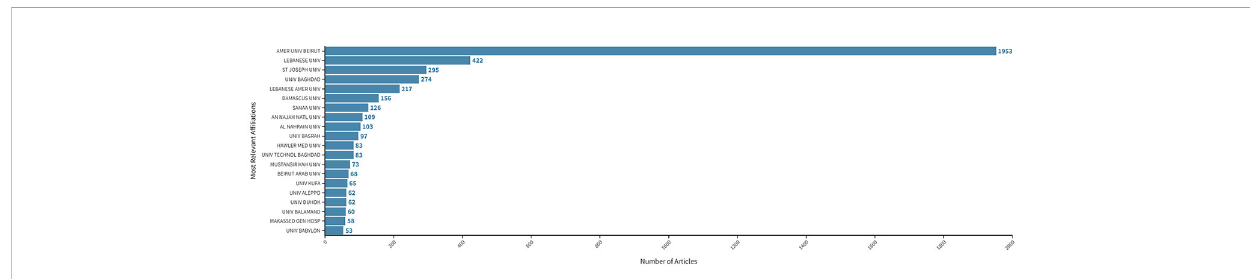
FIGURE 5 Most relevant af fi liations per article on cancer research in FCS in the MENA region from 2000 to 2021. From top to bottom: American University of Beirut, Lebanese University, Saint Joseph University, University of Baghdad, Lebanese American University, Damascus University, Sanaa University, An-Najah National University, Al Nahrain University, University of Basra, Hawler Medical University, University of technology Baghdad, Mustansiriyah University, Beirut Arab University, University of Kufa, University of Aleppo, University of Duhok, University of Balamand, Makassed general